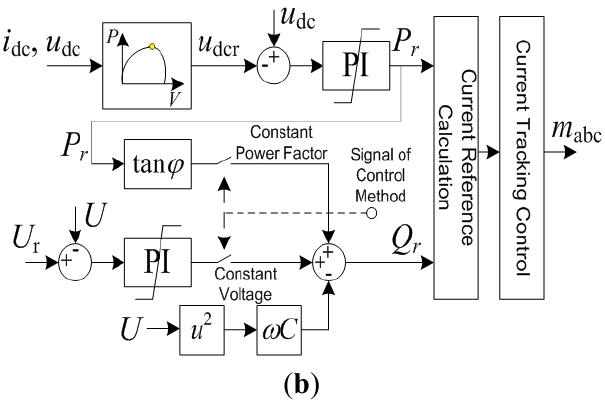
Figure 1. Grid-connected photovoltaic system: ( a ) The structure of PV generation system and ( b ) Power control of PV